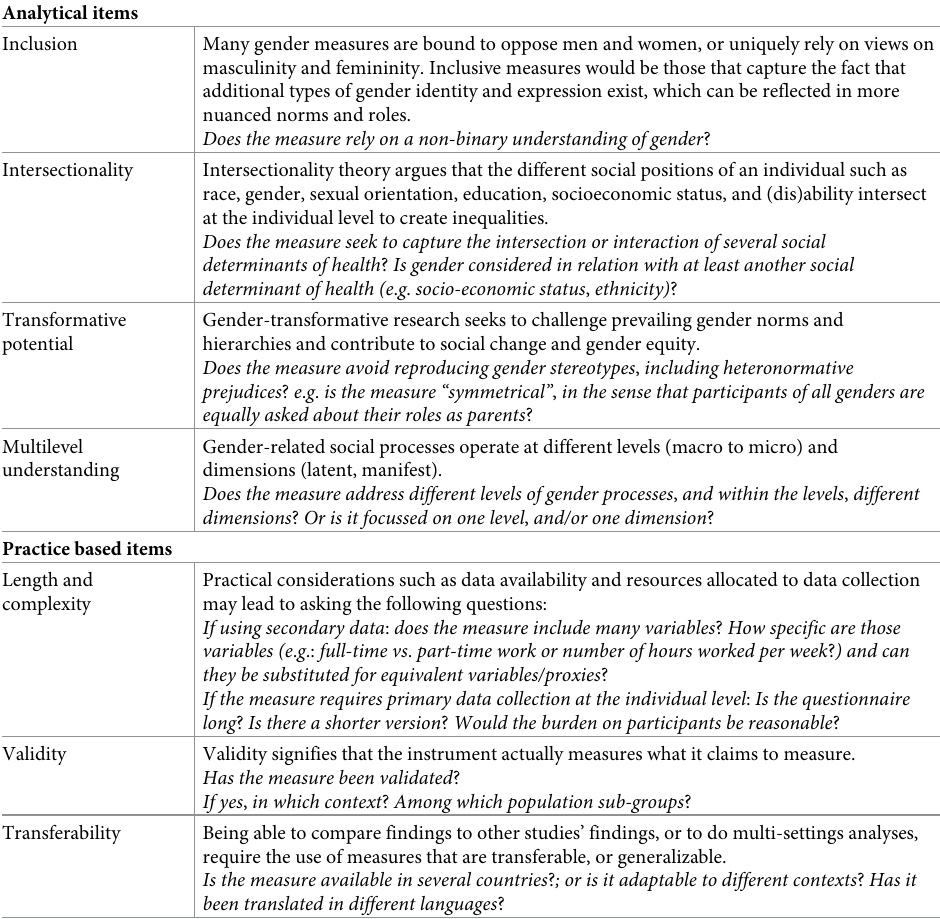
Table 2. Checklist to guide reflection on gender